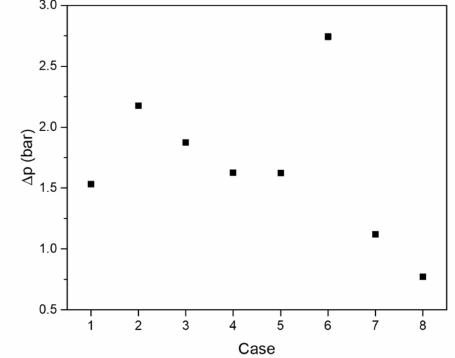
Figure 11. Area-averaged pressure difference between the front and rear of the